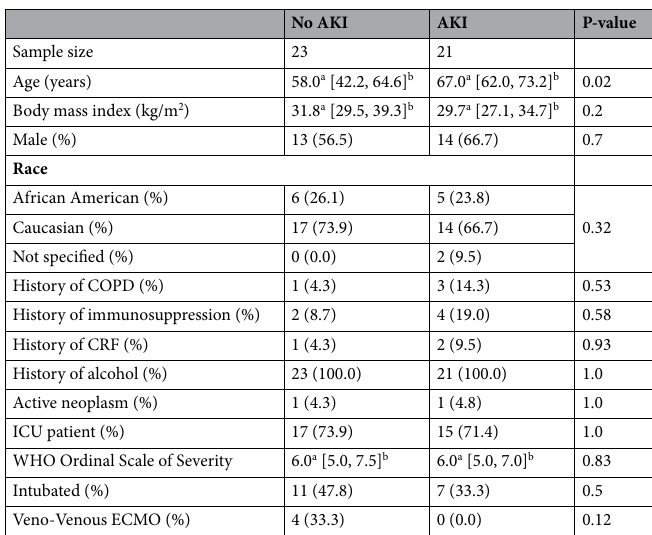
Table 2. Summary of patient demographics, history and disease severity. COPD, chronic obstructive pulmonary disease; CRF, chronic renal failure; ECMO, extracorporeal membrane oxygenation; ICU, intensive care unit. WHO Ordinal Scale of Severity includes metrics of respiratory support, vasopressors and ECMO. a Median. b Interquartile range.